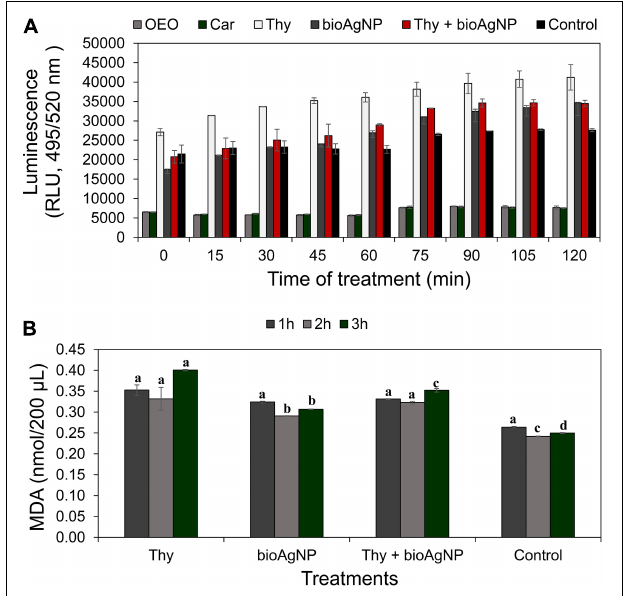
FIGURE 3 | Measurement of oxidative stress over time in E. coli ATCC 25922 exposed to antimicrobials at subinhibitory concentrations (oregano-derived antimicrobials and the bioAgNP individually and in combination) by quantification of intracellular reactive oxygen species (ROS) generation and lipid peroxidation levels. Controls indicate bacterial ROS and malondialdehyde (MDA) generation by cells without the antimicrobials. (A) ROS production levels expressed as relative light units (RLU) whose values are the mean ± standard deviation. (B) Lipid peroxidation levels measured by malondialdehyde (MDA) production after 1, 2, and 3 h of treatment. Values of MDA are the mean ± standard deviation. a − d Indicate statistically significant difference ( p < 0.05, Kruskal–Wallis test) among treatments and control at the same time in term of oxidative stress; different letters indicate difference, and same letters indicate absence of